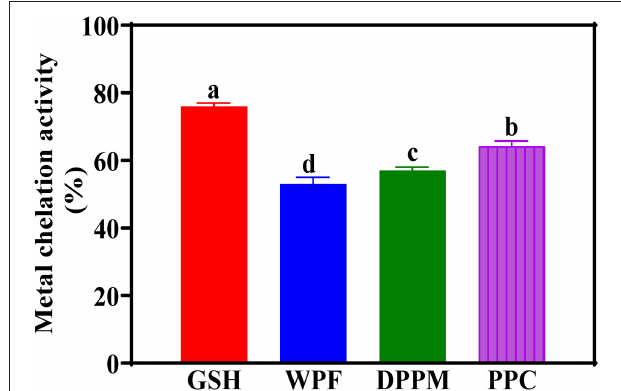
FIGURE 5 | Metal chelation activities of different peanut protein preparations (WPF, whole peanut flour; DPPM, defatted peanut protein meal; PPC, peanut protein concentrate) in comparison to glutathione (GSH) a natural antioxidant. Values are means ± std and bars with different letters are significantly different at p <